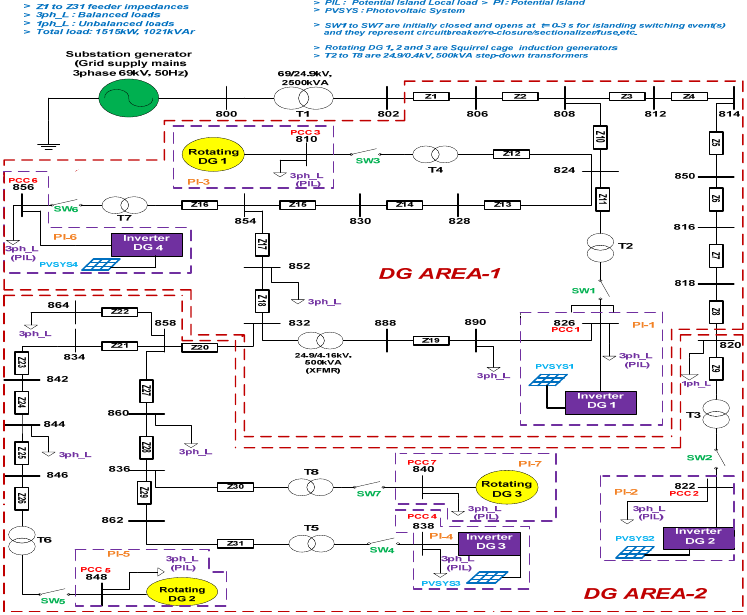
Figure 3. IEEE 34 bus distribution test feeder integrated with PV inverter and rotating DG sources.